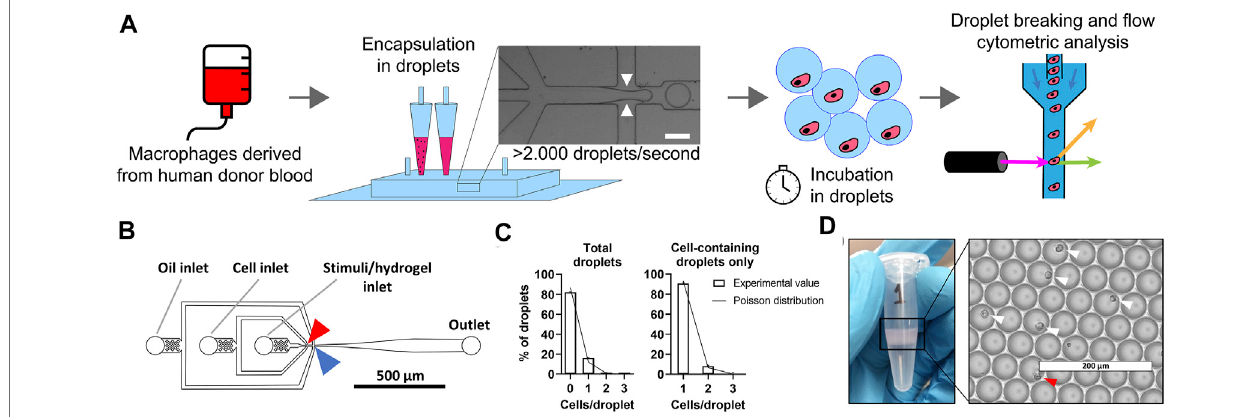
FIGURE 1 | Droplet-based micro fl uidics for high-throughput production of identical single-cell cultures. (A) Schematic of work fl ow for single-cell culture and the single-cell analysis of primary macrophages. White arrows represent were oil cuts of droplets, scale bar is 50 μ m. (B) To-scale layout of micro fl uidic chip with inlets and outlet indicated by grey lines, red arrow indicates location where cells and stimuli are combined, blue arrow indicates where droplets are formed. Channel height measured 30 μ m, scale bar represents 500 μ m. (C) Distribution of cells in droplets for both total droplets and empty droplets excluded. Bars represents data of 1,000 manually counted droplets in two independent experiments performed at a cell concentration of 2 × 10 6 cells/ml at droplet formation point. The plotted line represents Poisson distributed values based on the same concentration. (D) Eppendorf tube containing one batch of 2.5 × 10 6 droplets as collected from micro fl uidic device, with droplets fl oating on excess oil. Light microscopy picture of monodisperse droplets on glass slides, white arrows indicate single cells, red arrow indicates double cells. Scale bar equals 200 μ m.